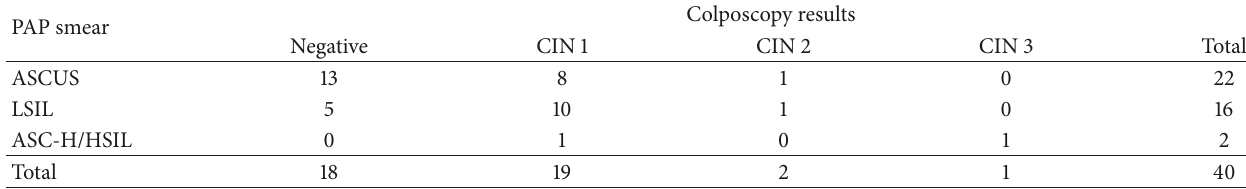
Table 5: Pap smears with matched colposcopy results within 6 months for HIV+ women > 65 (𝑛 = 40) . PAP